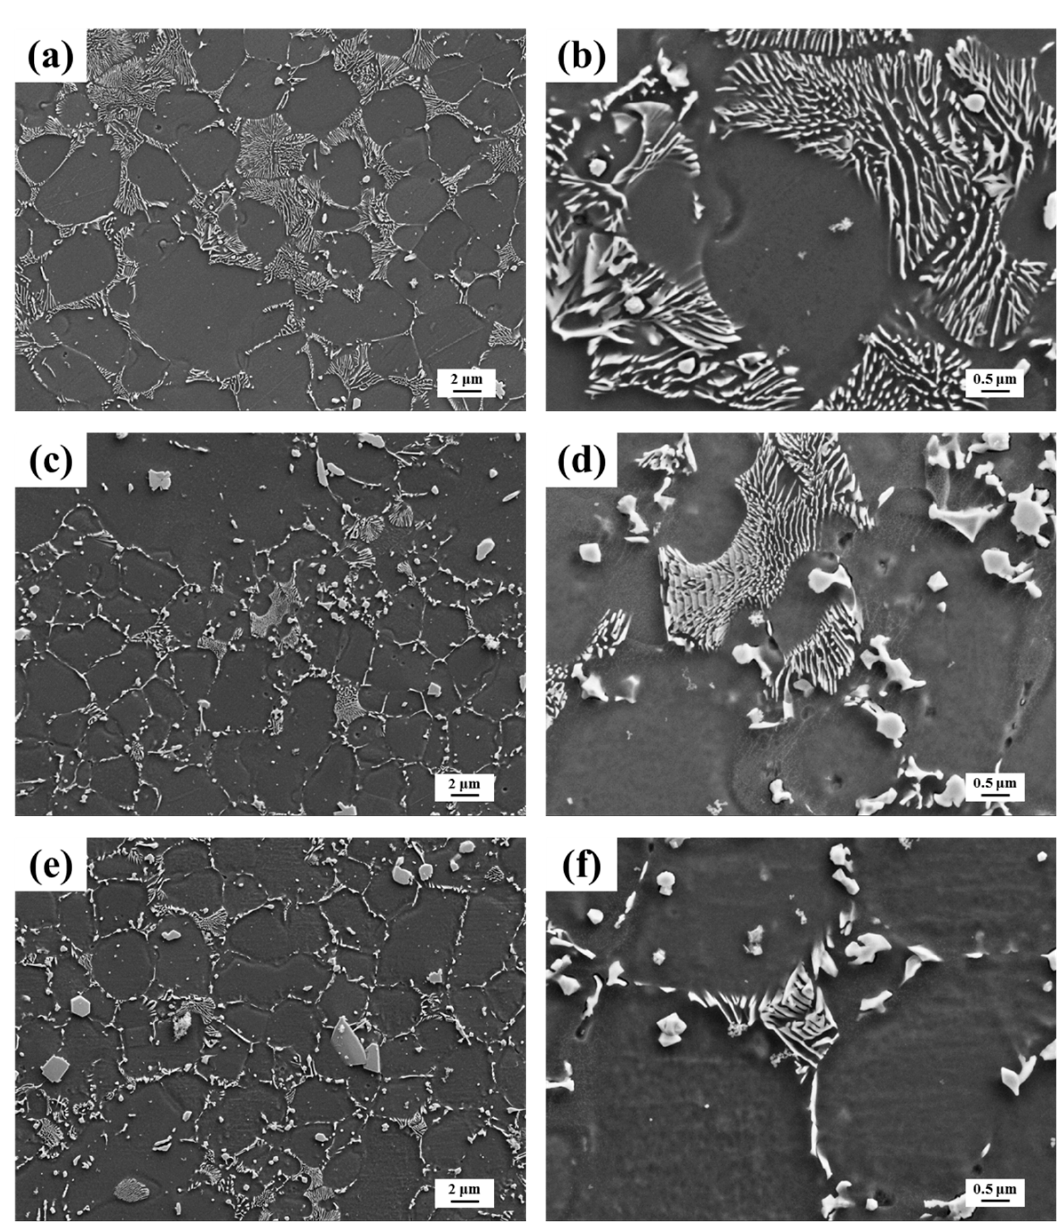
Figure 2. SEM images of the Mg-4Al-4 (La, Ce) alloy: ( a , b ) Mg-4Al-4 (La, Ce); ( c , d ) Mg-4Al-4 (La, Ce)-1Sm; ( e , f ) Mg-4Al-4 (La, Ce)-2Sm.